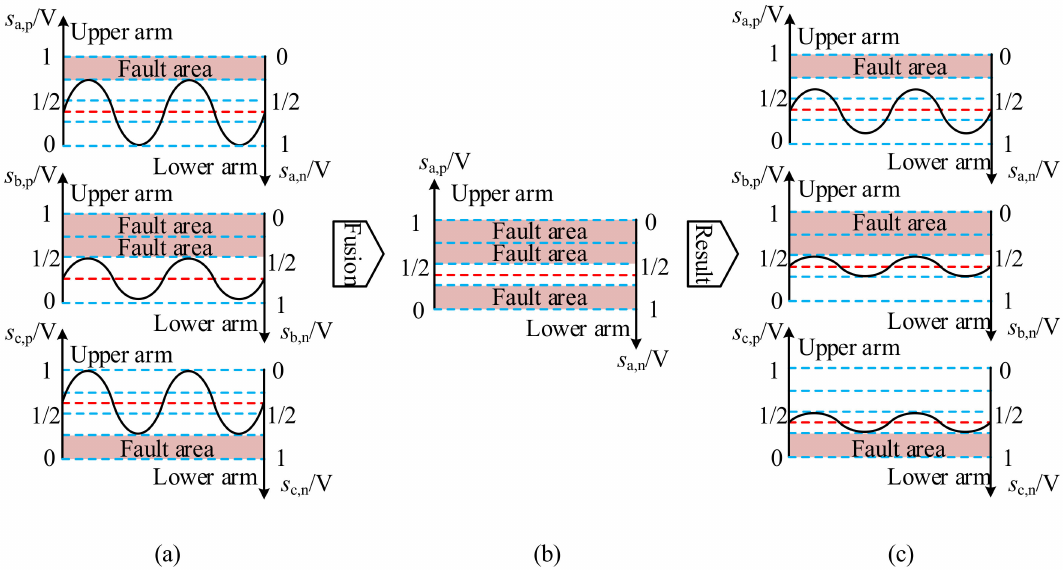
Figure 7. The fault information fusion of a three-phase bridge arm ( N = 4). ( a ) Three-phase modulation wave after single-phase fusion; ( b ) Modulation area; ( c ) Three-phase modulation wave after three-phase